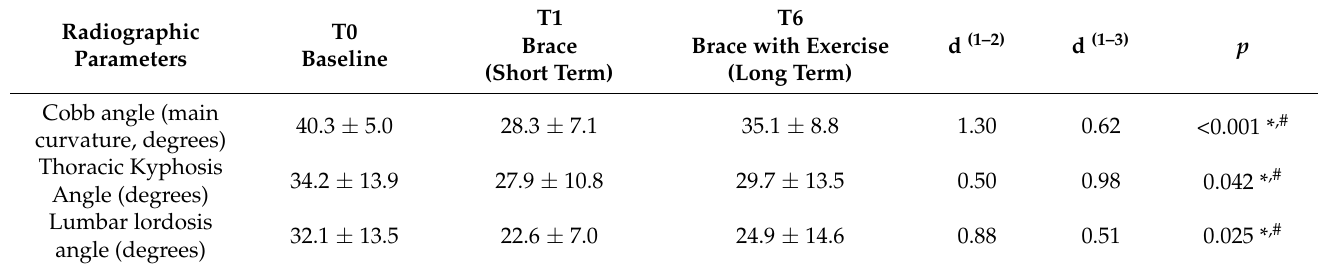
Table 5. Comparisons of radiographic parameters between the different timepoints: